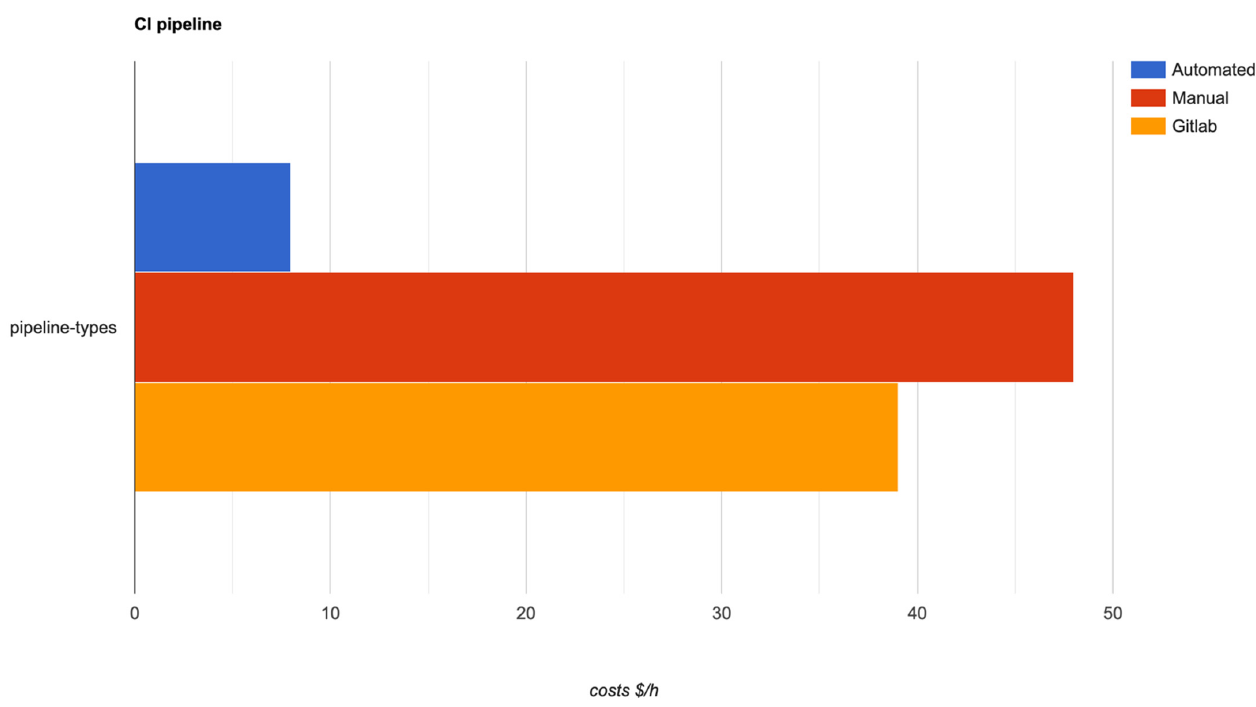
Figure 14. Pipeline type infrastructure costs.